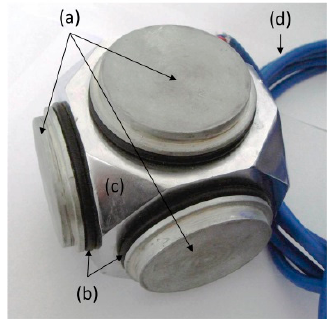
Figure 1. External view of 3D comprehensive stress transducer (( a ). sensor faces; ( b ). sealing washer; ( c ). supporting body; ( d ). cable).